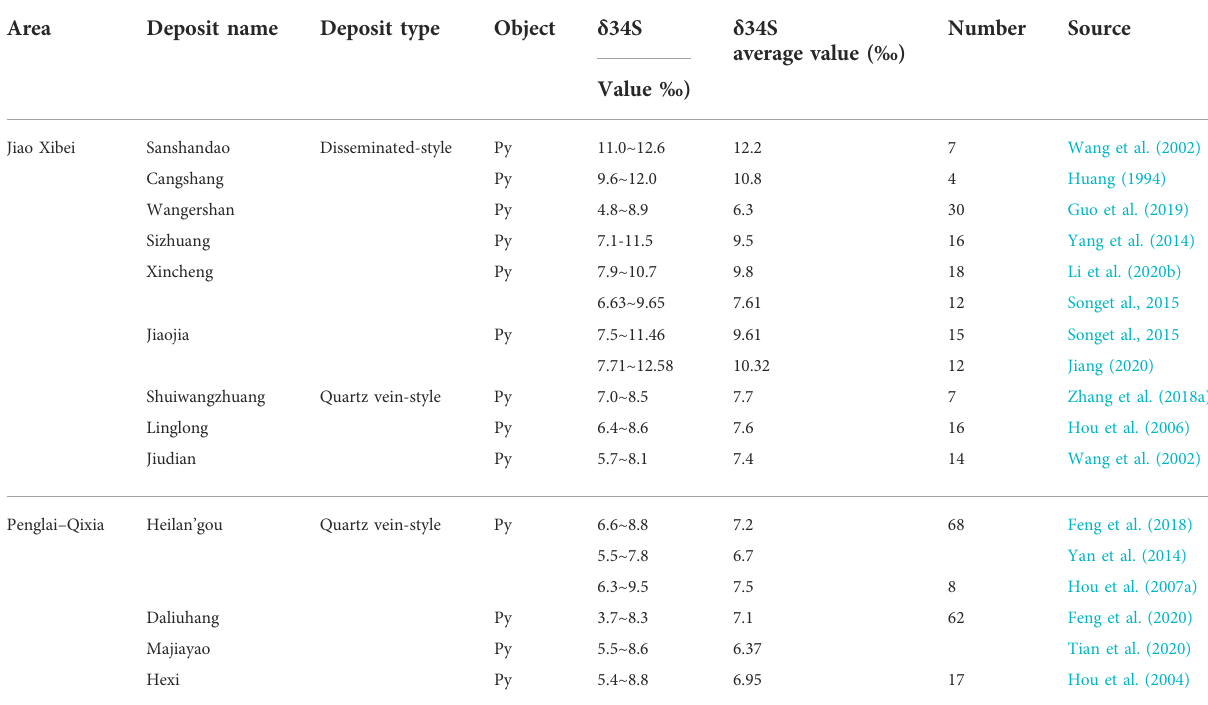
TABLE 4 Sulfur isotopes of typical gold deposits in North